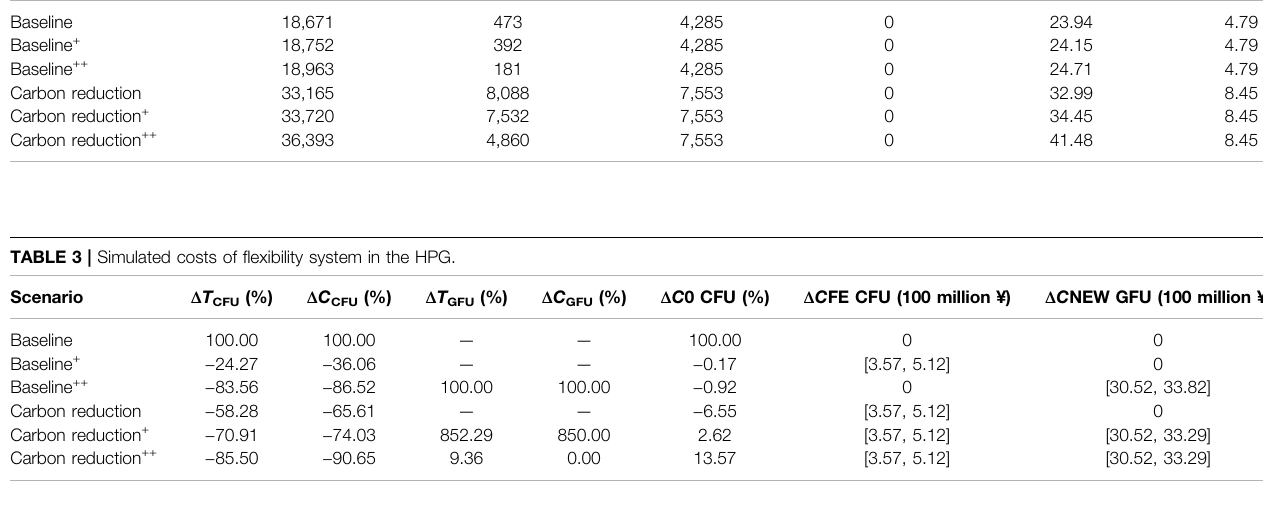
TABLE 2 | Simulation results of power system fl exibility in the HPG. Scenario